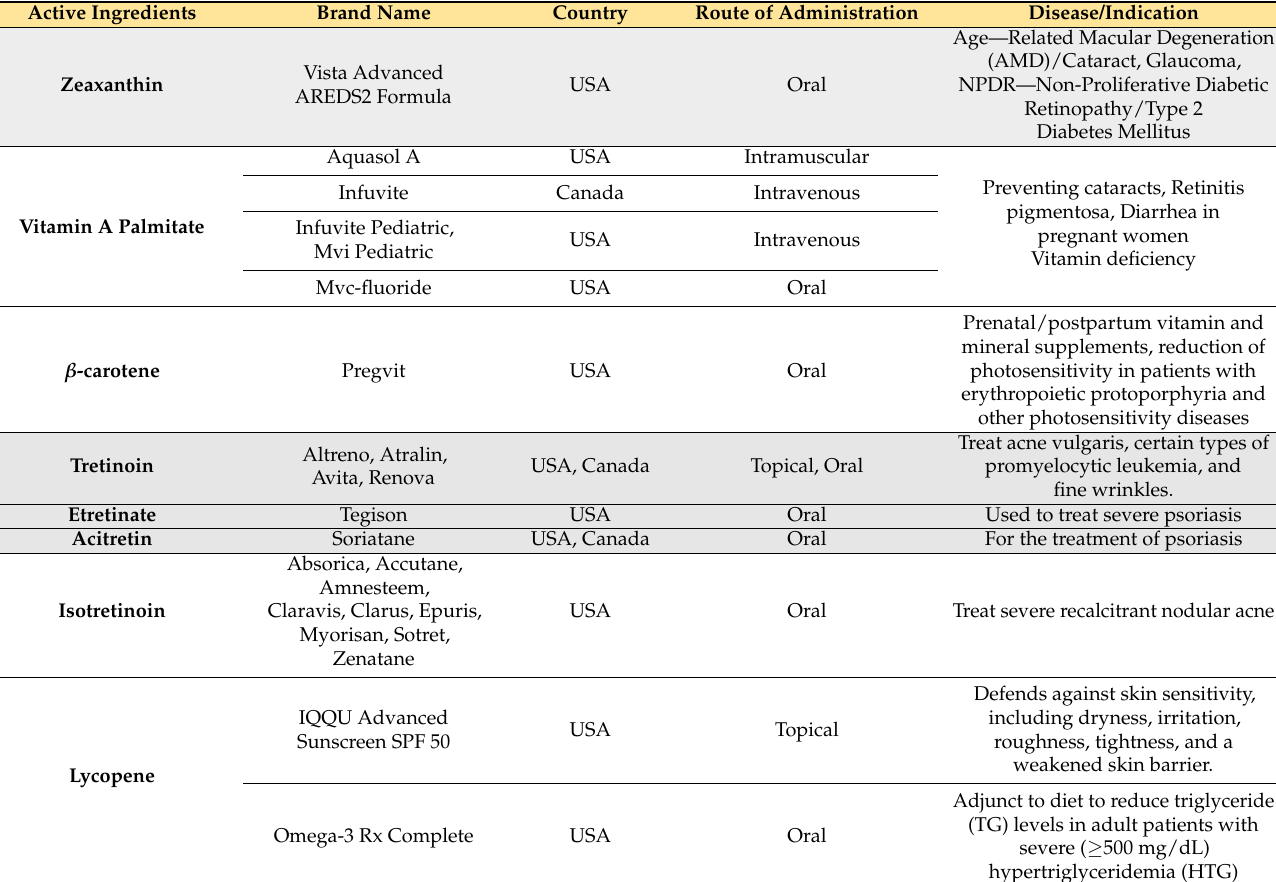
Table 1. List of marketed carotenoid-based drugs and